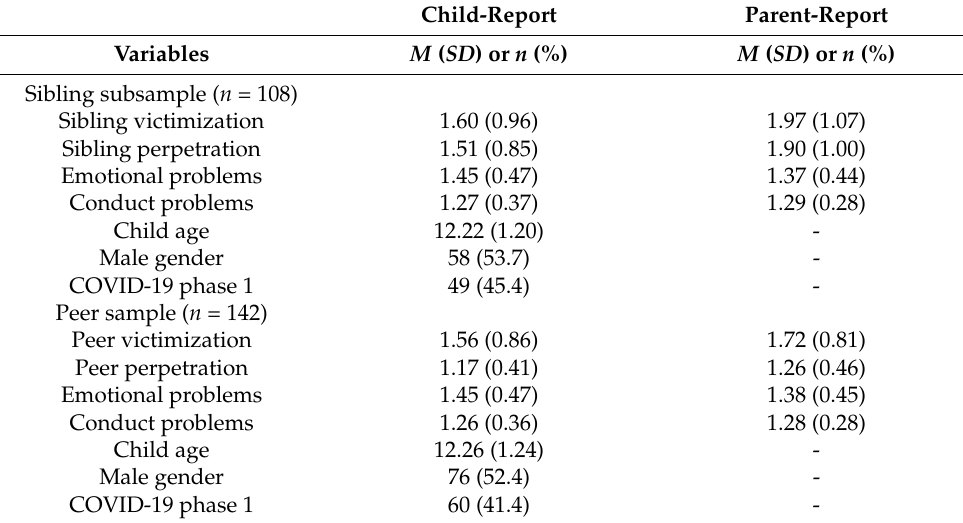
Table 1. Descriptive statistics of key study variables.